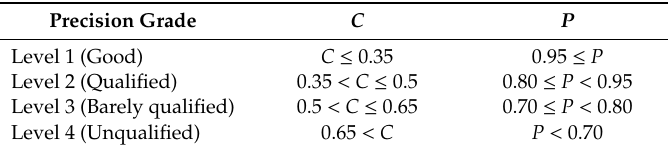
Table 2. The precision grade of accuracy test.